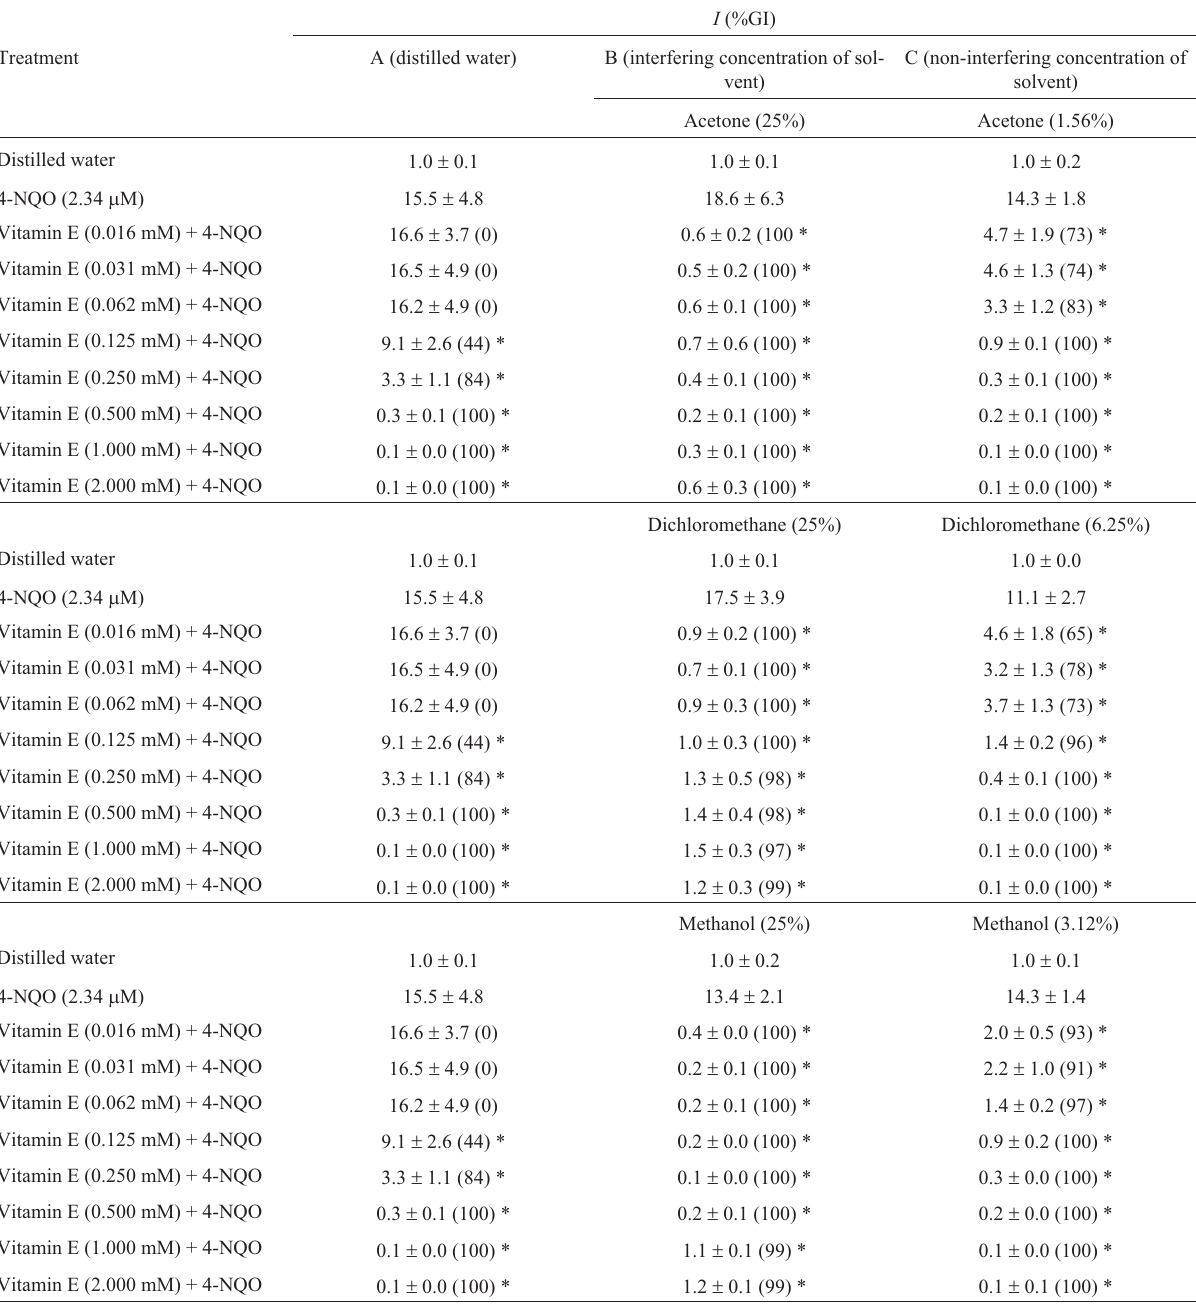
Table 5 - Influence of solvents on the antigenotoxicity of vitamin E against 4-NQO-induced DNA damage in E. coli PQ37